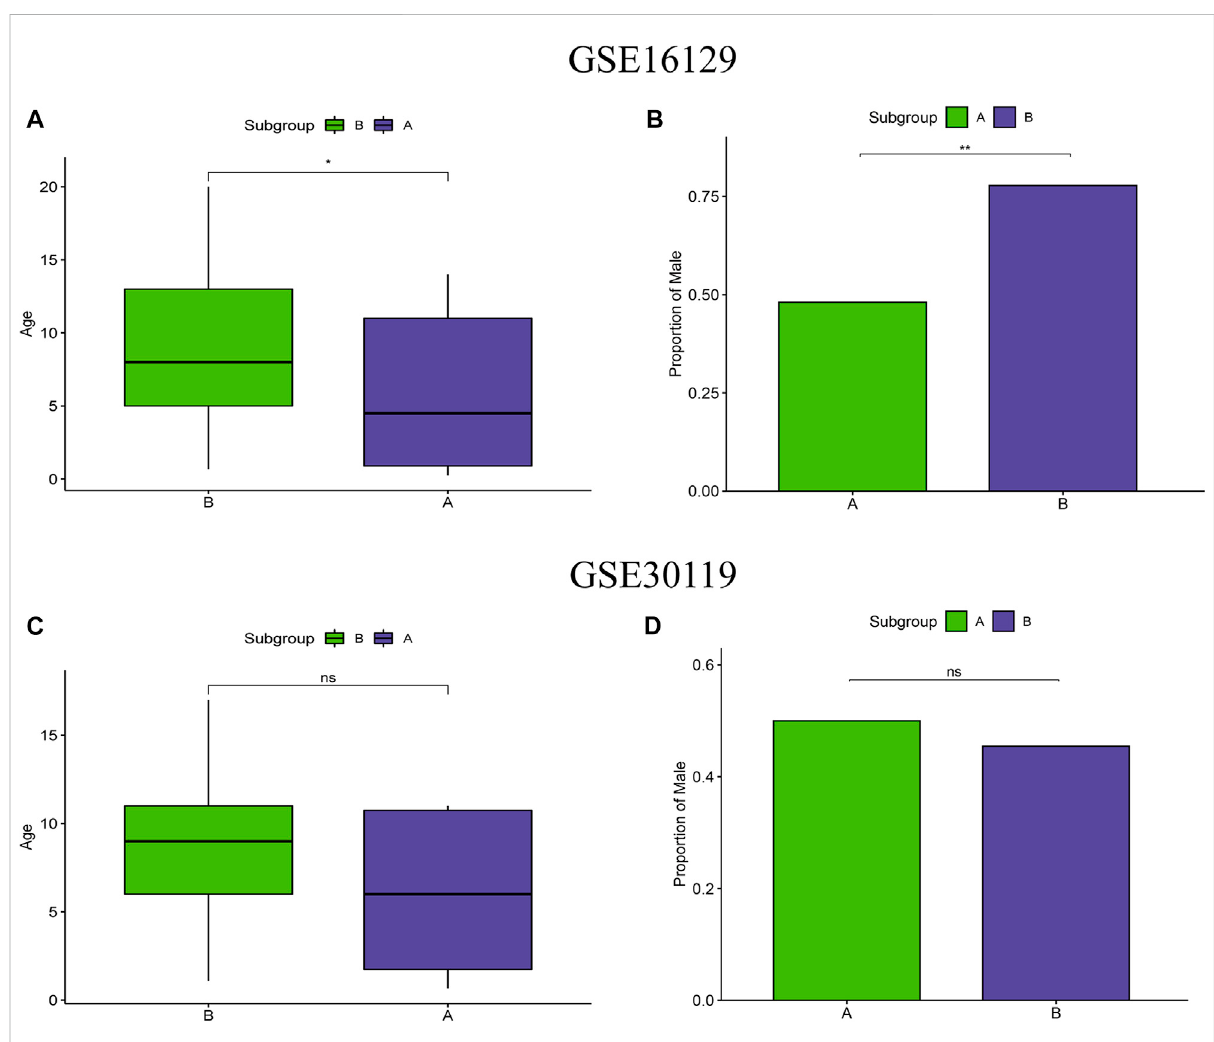
FIGURE 5 Clinical correlation analysis of two m6A clusters based on the GSE16129 and GSE30119 datasets. Differences in age (A) and proportion of male (B) betweentwom6AclustersbasedontheGSE16129dataset.Differencesinage (C) andproportionofmale (D) betweentwom6Aclustersbasedon the GSE30119